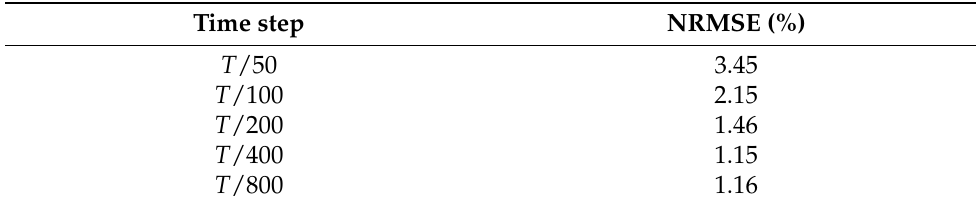
Table 5. NRMSE value for each time step analyzed.